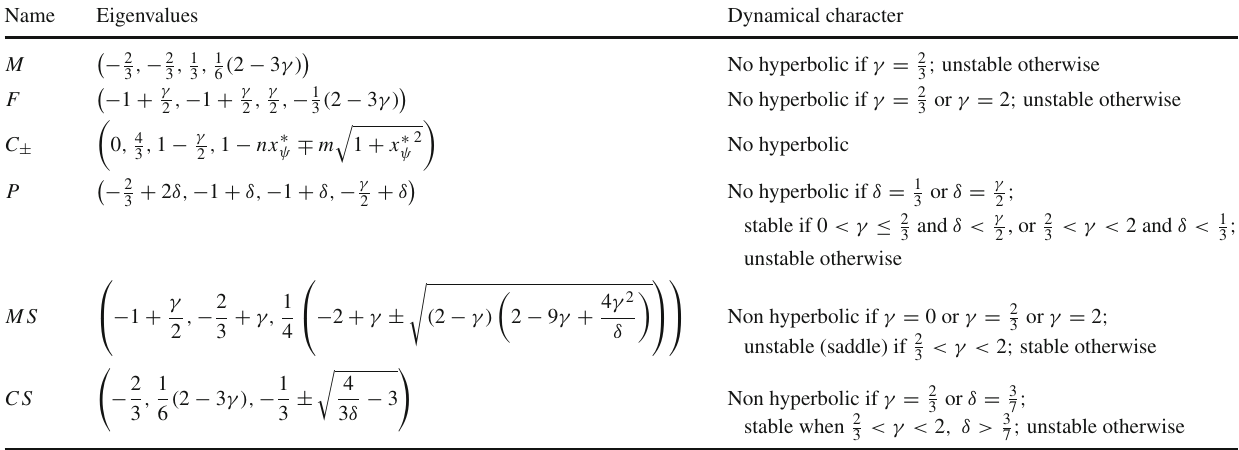
Table 2 Eigenvalues, and dynamical character of the fixed points for y ≥ 0 and z ≥